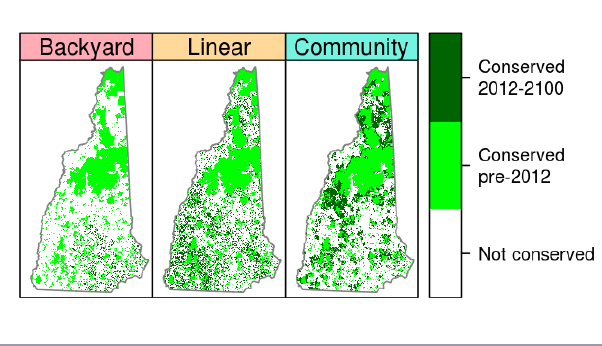
Fig. 6. Scenarios for land conservation in 2100 for three scenario families: Backyard, Linear, and Community. Light green = land conserved in the present day, dark green = newly conserved land under each